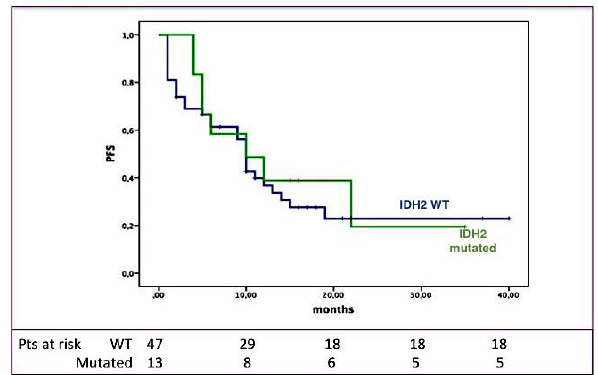
Figure 2. IDH2 mutational status and progression-free survival (PFS). PFS according to the presence/absence of IDH2 mutations; as shown, PFS was not different between IDH2-unmutated (blue) and -mutated (green) patients.